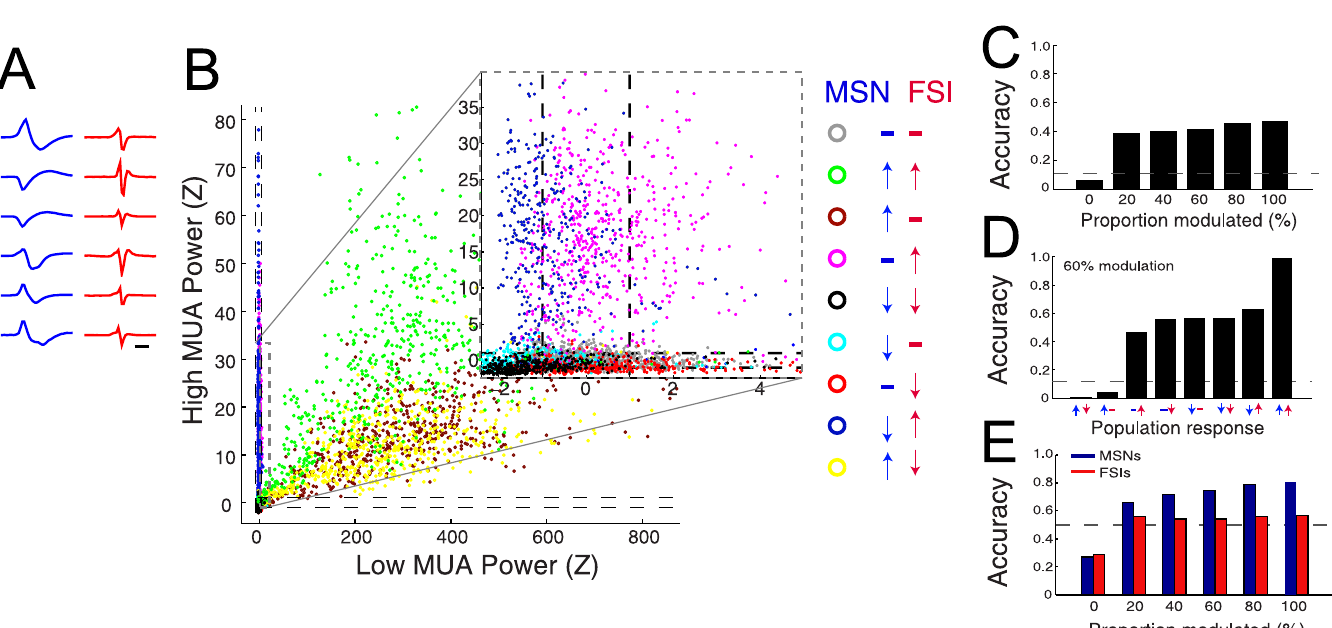
Fig 7. In the absence of well-isolated spikes, the spectral signature of MUA is a poor predictor of evoked neuronal ensemble dynamics. A) Representative MSN (blue) and FSI (red) spike waveforms used in simulation. Time scale = 1ms. B) Results of simulations of high frequency activity derived from spiking. Data is from simulation where 60% of neurons were modulated. Each data point represents the low and high frequency power during 10ms time windows in the simulation. Colored data points represent time bins where the instantaneous firing rate of certain populations deviated from baseline. For each color, the direction of simulated spiking activity for MSNs and FSIs is shown in the legend on the right panel. For example, green dots represent 10ms time bins where both MSNs and FSIs increased in spiking activity. Black dotted lines represent the significance threshold for determining if low or high MUA reached significance ( > 2SD) during a time window. The gray dotted insert shows a detailed version of data on the left of the figure. C-E) Classifier results. C) Overall accuracy for correctly predicting population activity as a function of the proportion of neurons whose activity was modulated during the simulation. Dotted line denotes chance level (8-way classifier). D) Relationship of the accuracy of detecting each type of firing rate deviation on the overall accuracy of technique. Data is shown for simulation where the input drives 60% of neurons. E) Accuracy of predicting MSN dynamics with low MUA and the accuracy of predicting FSI dynamics with high MUA. Data shown as a function of the proportion of neurons modulated during simulation.